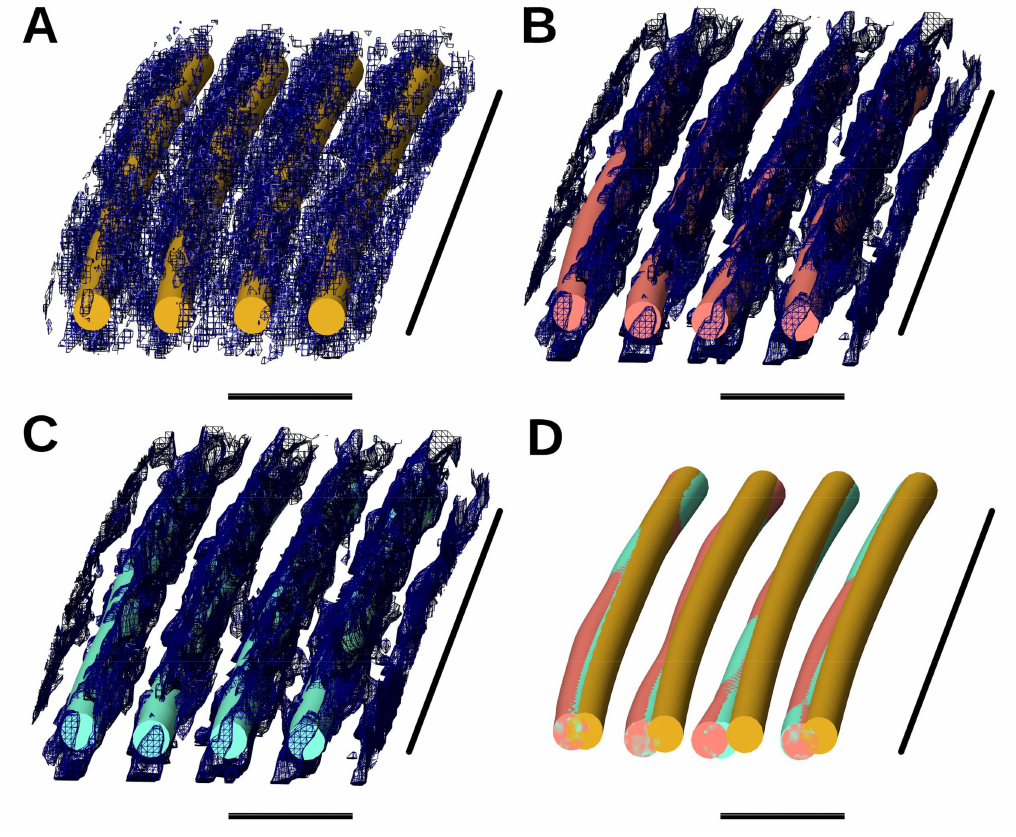
Figure 5. A local view of the filaments built with various implementations. ( A ) Filaments built manually (gold) overlaid with the original map; ( B ) filaments built using the one-peak method (salmon) overlaid with the longitudinally averaged density map; ( C ) filaments built using the seven-peak method (aquamarine) overlaid with the same map as in ( B ); ( D ) superposition of the three sets of filaments in ( A – C ). For ( A – D ), the horizontal scale bar is 20 nm, and the vertical scale bar is 630